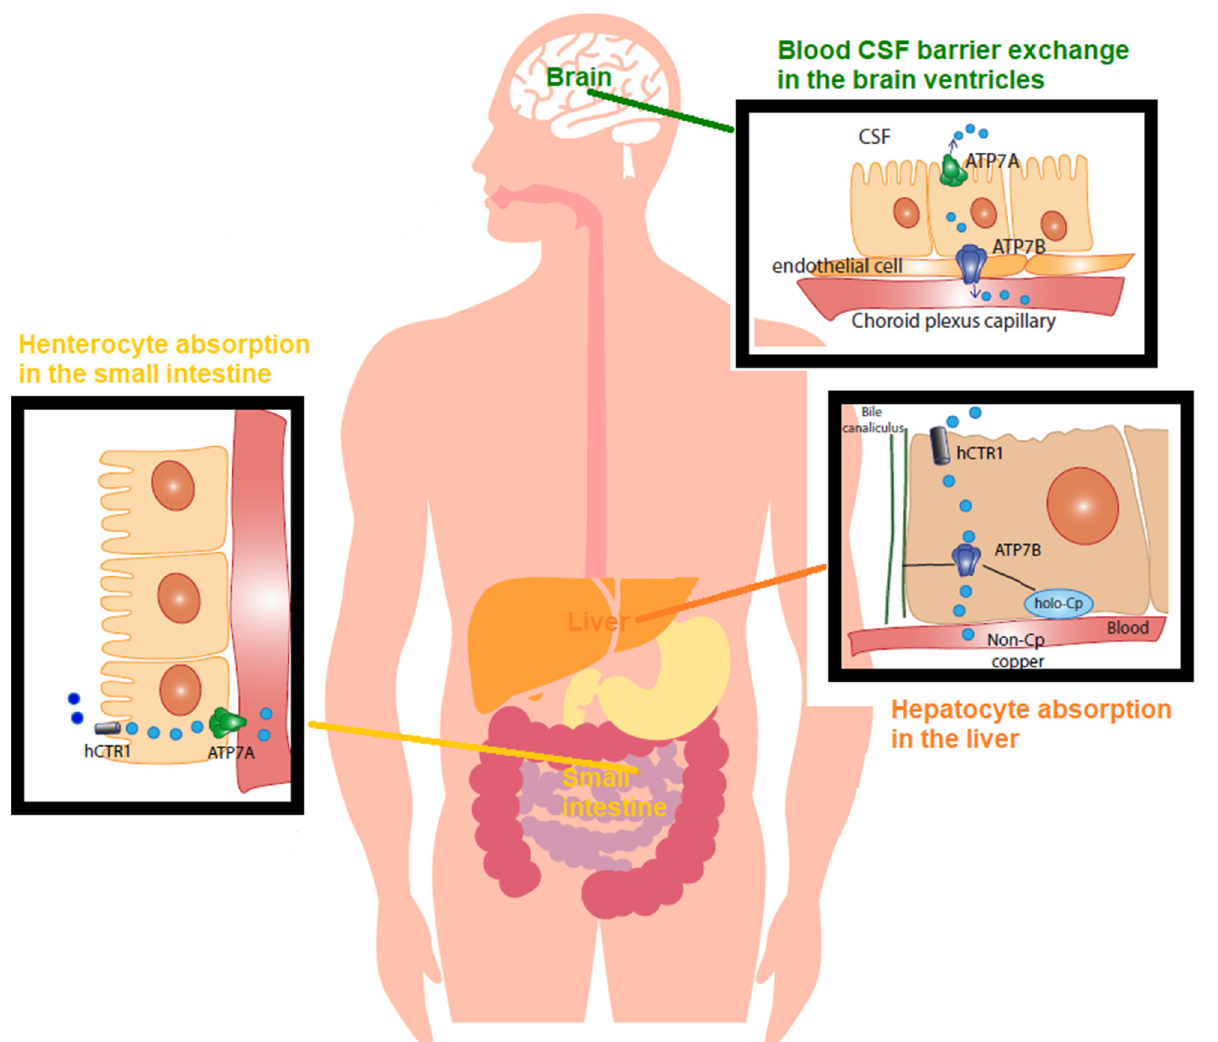
Figure 1. Copper (Cu) in physiology The recommended dietary allowance (RDA) for Cu is 0.9–1.3 mg/day. This represents the intake level sufficient to meet the nutrient requirements. Accordingly, humans normally ingest 1.5 mg/day of Cu via beverage and foods. The Cu balance is determined by the equilibrium between the rates of dietary absorption from diet and excretion through stools and bile, and it is tightly regulated. In the small bowel, concerning Cu absorption into the enterocyte, Cu 2+ is reduced by reductases. CTR1 imports Cu 1+ within the cell. Cu is absorbed as a pool of low molecular weight soluble complexes and pumped out of the enterocyte’s basolateral membrane by the Cu-transporting P-type ATPase (ATPase7A) via the vesicular compartment (not shown). Cu is then transported, mostly bound to amino acids, peptides, micronutrients, and albumin, and transported into the serum. From the gut, this pool of low molecular weight Cu, known as non- ceruloplasmin (non-Cp) Cu, travels to the liver through the portal vein. The liver represents the main organ of storage and utilization of Cu. CTR1 facilitates Cu intake in the hepatocytes and delivery to chaperones. In the liver, ATPase7B, the homologue of enterocytes’ ATPase7A, incorporates Cu into ceruloplasmin. Of the Cu, 75–95% tightly binds to ceruloplasmin, whereas the remainder loosely binds to and is exchanged among albumin, α 2 macroglobulin, amino acids, peptides, and several micronutrients. Hepatocytes limit the non-Cp Cu concentration in the blood to 0.008–1.6 µmol/L (equivalent to 0.05–1 mg/dL), which is the upper limit of the normal reference range of non-Cp Cu in serum after an overnight fast. An excess of Cu induces the translocation of ATPase7B from the trans-Golgi network to the canalicular membrane (via the vesicular compartment), where the metal is released into the bile. As for blood barrier exchange in the brain ventricles, the endothelial cells of the brain’s capillaries constitute the blood–brain barrier (BBB). The cerebrospinal fluid (CSF) is the biological fluid that surrounds the brain and fills the brain ventricles, and it is secreted by the choroid plexus. The Cu in CSF has values in the range of 0.5–2.5